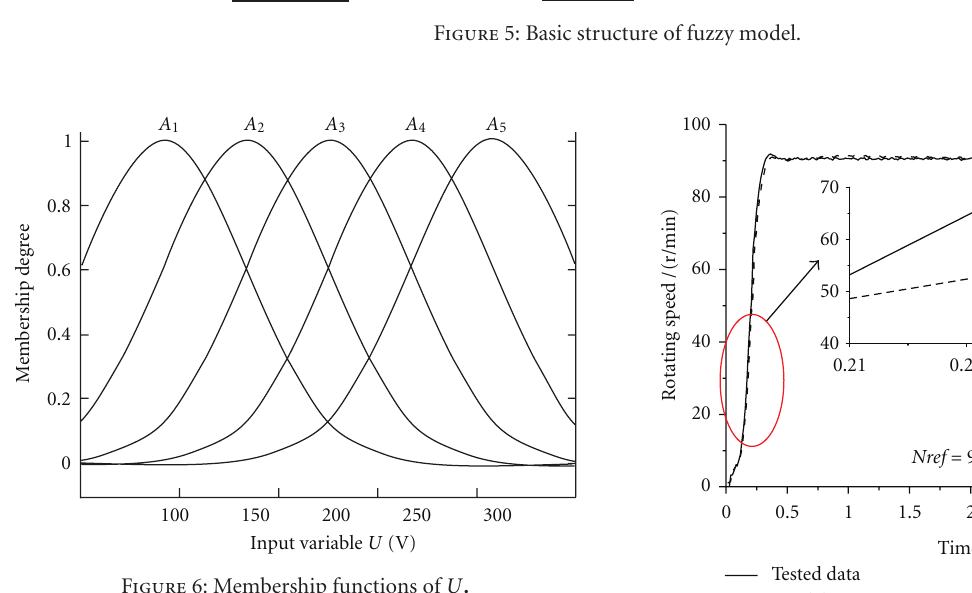
Figure 6: Membership functions of U .